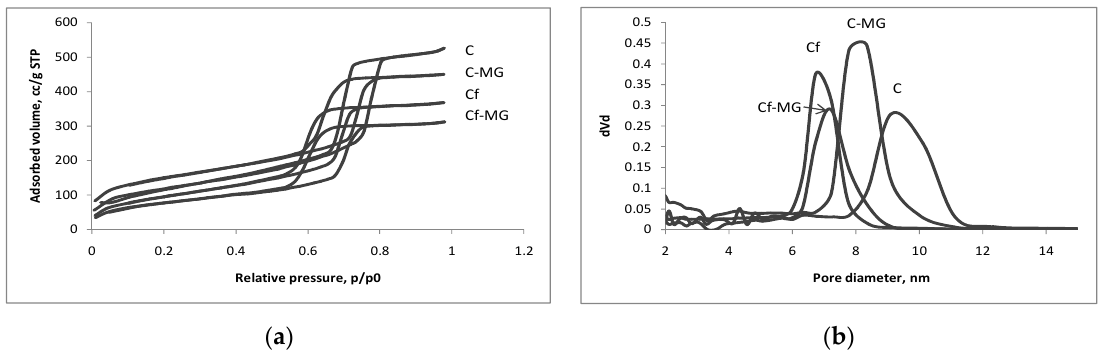
Figure 1. ( a ) N 2 adsorption-desorption isotherms; ( b ) corresponding Barrett-Joyner-Halenda (BJH) pore size distribution curves of mesoporous SBA-15 silica (C), APTES (3-aminopropyltriethoxysilane)- functionalized mesoporous SBA-15 silica (Cf), and magnolol-loaded APTES-functionalized mesoporous SBA-15 silica material (Cf-MG).